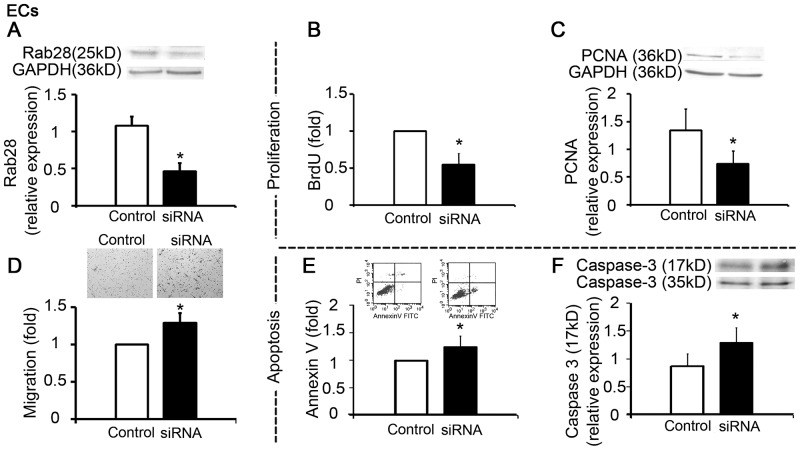
Rab28 knockdown changed cell proliferation, apoptosis and migration in ECs.(A) Target siRNA transfection down-regulated the expression of Rab28. (B, C) The repressed expression of Rab28 decreased the proliferation, (D) increase the migration, (E, F) and apoptosis of ECs. All results are given as mean ± s.d., *P<0.05, n = 7 each.